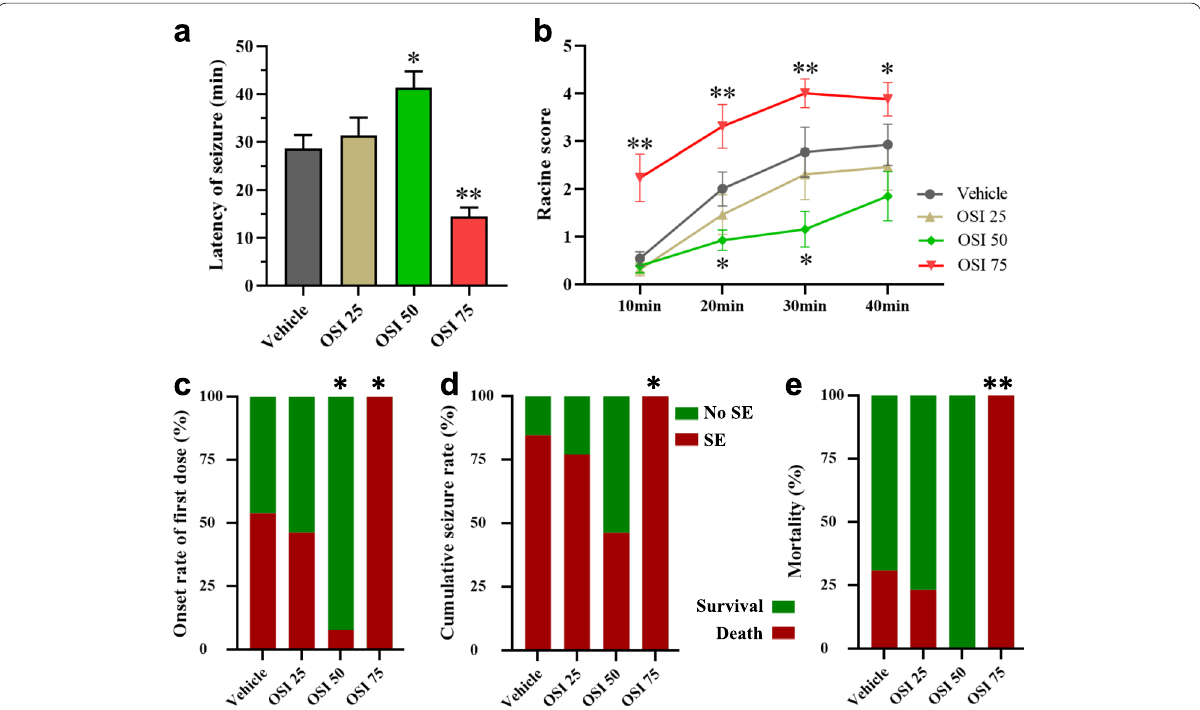
Fig. 2 Effects of OSI-906 on acute epileptic seizures. ( a ) 50 mg/kg OSI-906 extended the seizure latency. ( b ) 50 mg/kg OSI-906 significantly reduced Racine score, but 75 mg/kg OSI-906 aggravated the severity of seizures. ( c & d ) First-dose and cumulative stage 4–5 seizure rates. ( e ) Effects of OSI-906 on mortality in acute rats. Bars represent mean SEM ( n 13 for each group). * P < 0.05 and ** P < 0.01 compared to the control ± =